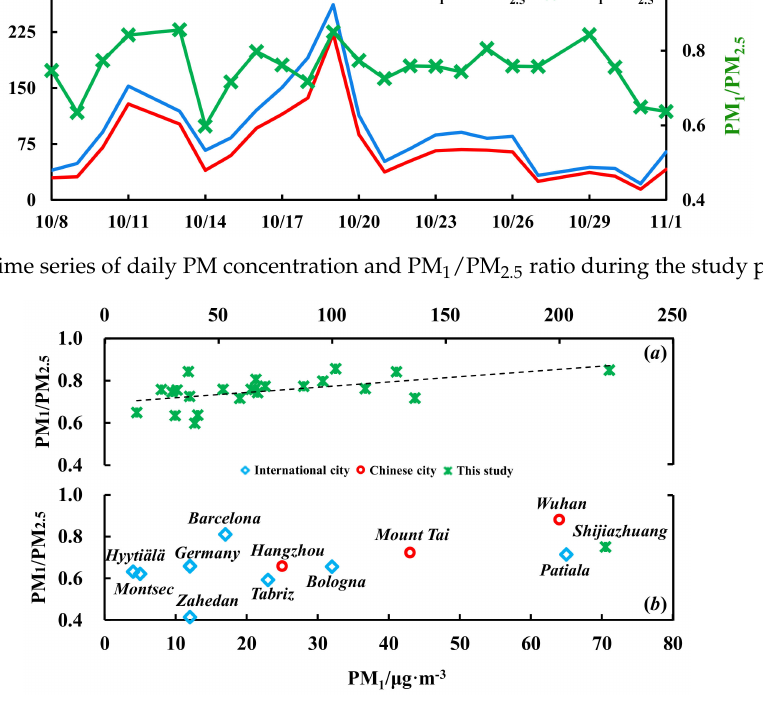
Figure 3. The ratio of PM 1 /PM 2.5 as a function of PM 1 concentration in this study ( a ) and in other studies ( b